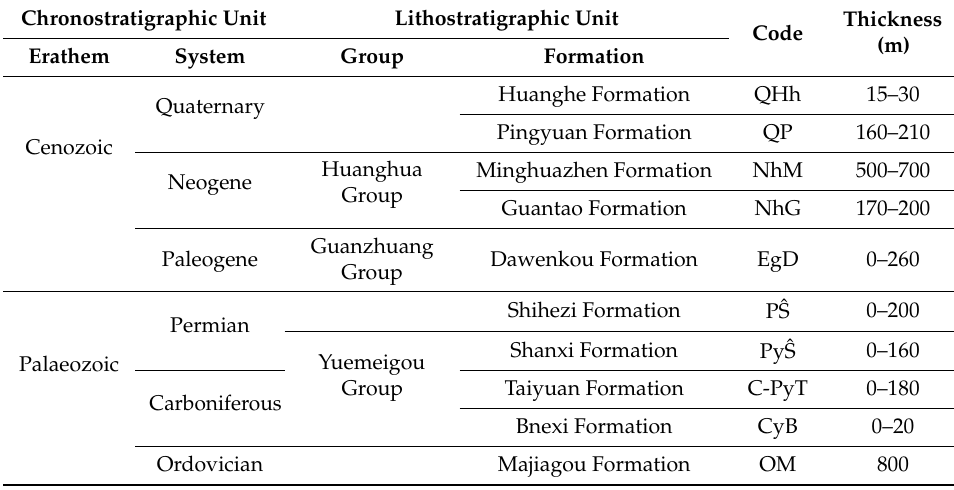
Table 1. Summary table of stratigraphic